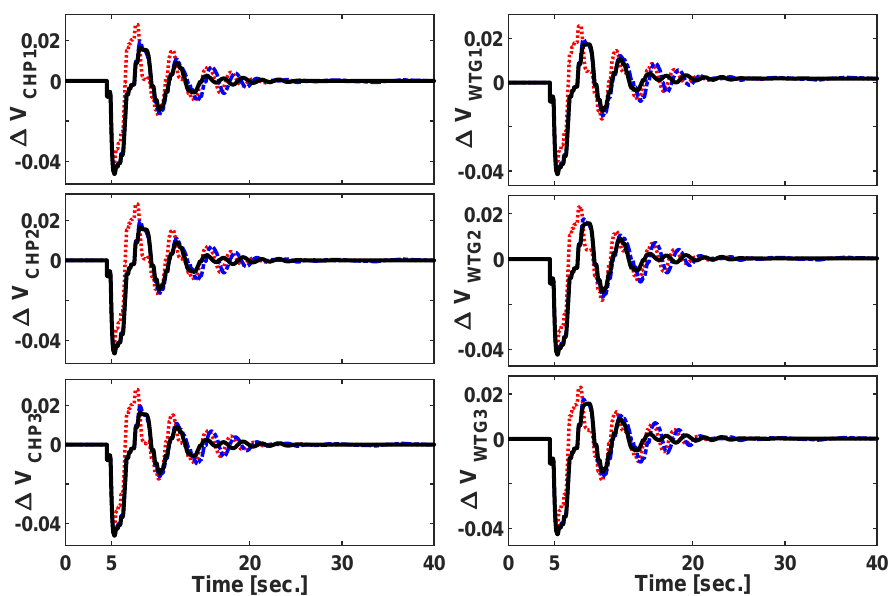
Figure 17. The oscillations of voltage at the generator buses in scenario 1; black(solid): RL-PID, blue (dashed–dotted): F-PID, red (dotted):